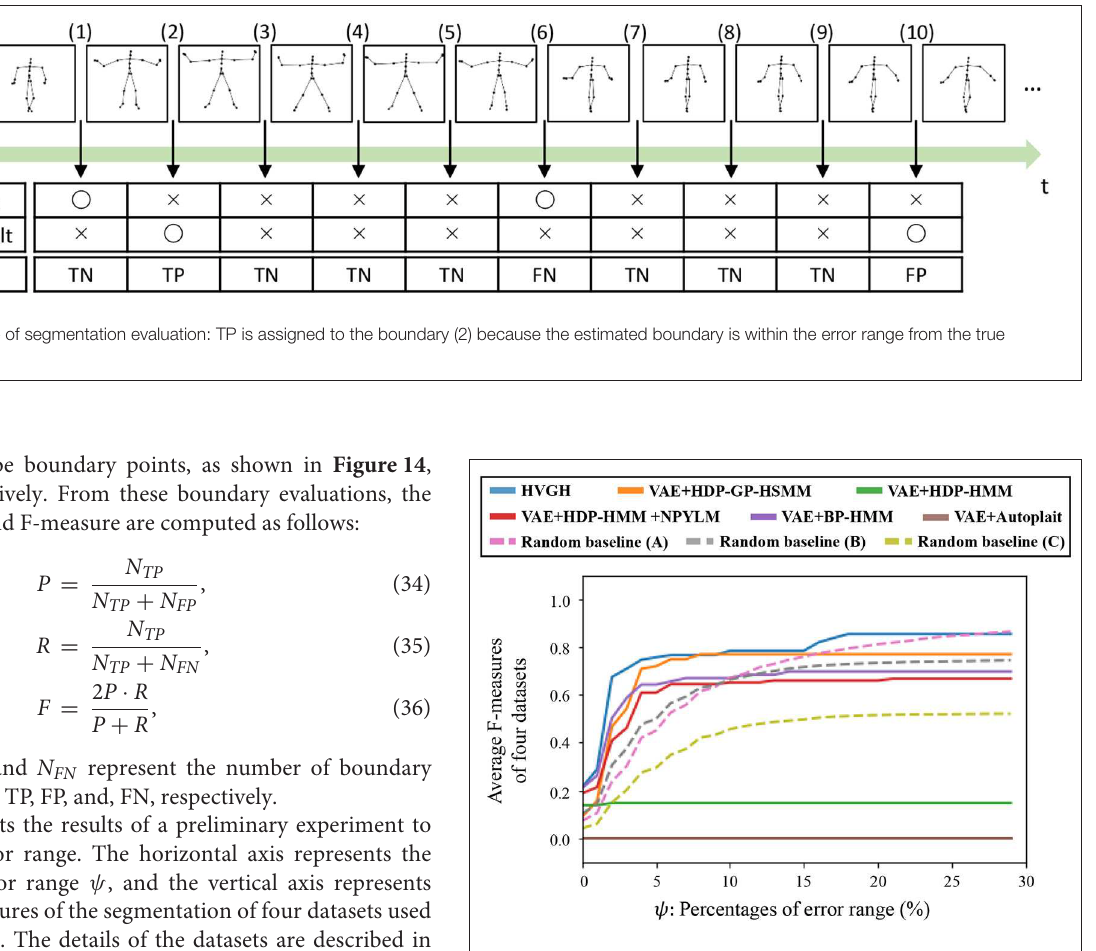
FIGURE 15 | Variation of F-measure with the error